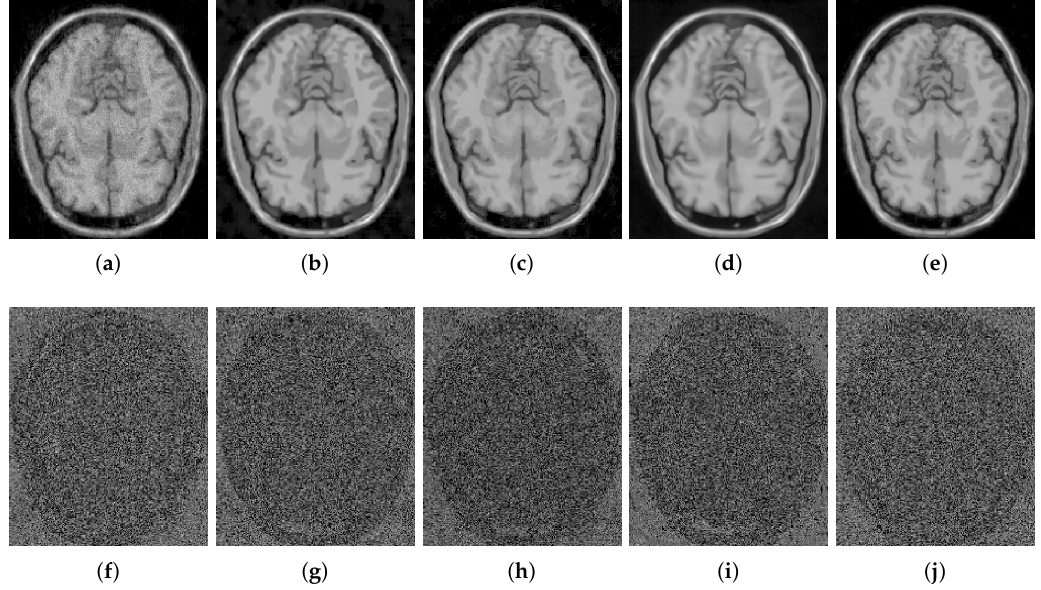
Figure 11. Residuals of the different results produced by the application of the methods evaluated on the noise-free T1w synthetic MR image of Figure 10a corrupted with 9% Rician noise. ( a – e ) are the denoising results of the methods KSVD, PRINLM, BM4D, DnCNN and NLSD, respectively. ( f – j ) are the corresponding